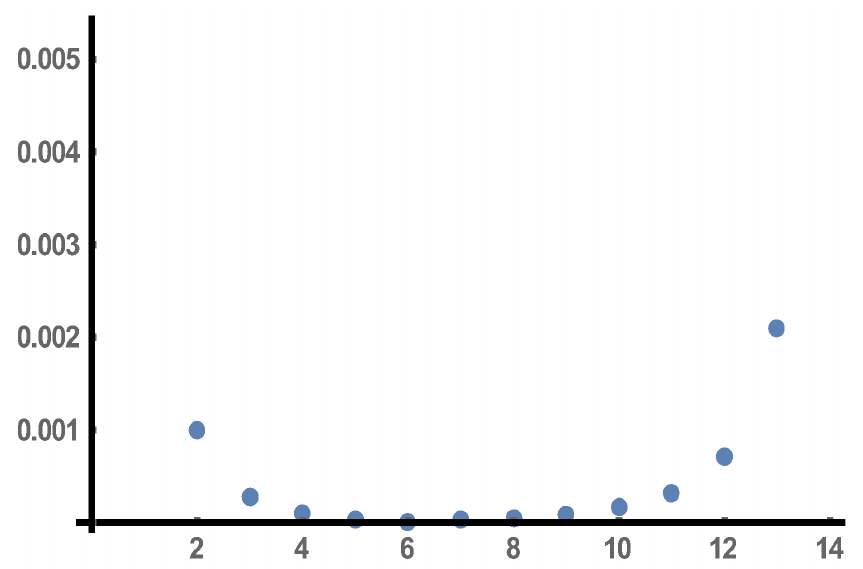
Figure 9. Errors between the 14 EDMD approximating trajectories and real data measured by the l 2 (Euclidean) norm.